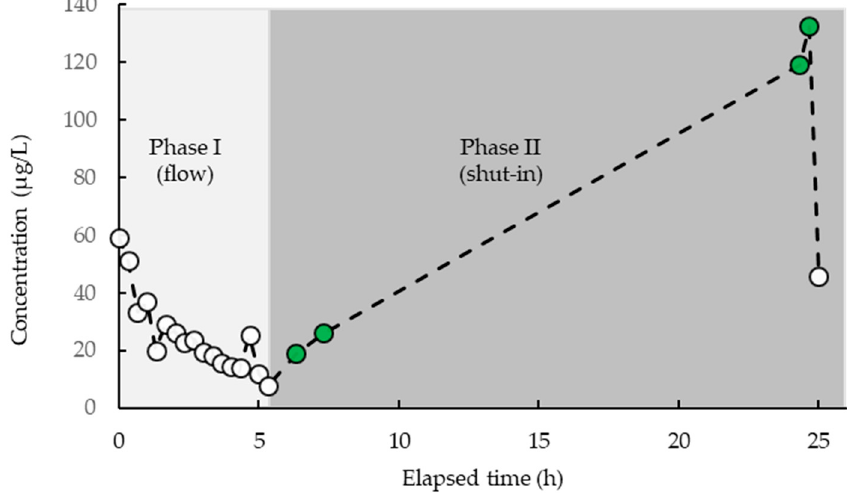
Figure 6. REE concentration (in µg/L) in effluent PLS collected during flow-through leaching of Middle Kittanning underclay (UC-02) powder. Black dots denote sampling points taken during continuous flow. Green dots indicate samples taken after various shut-in times.